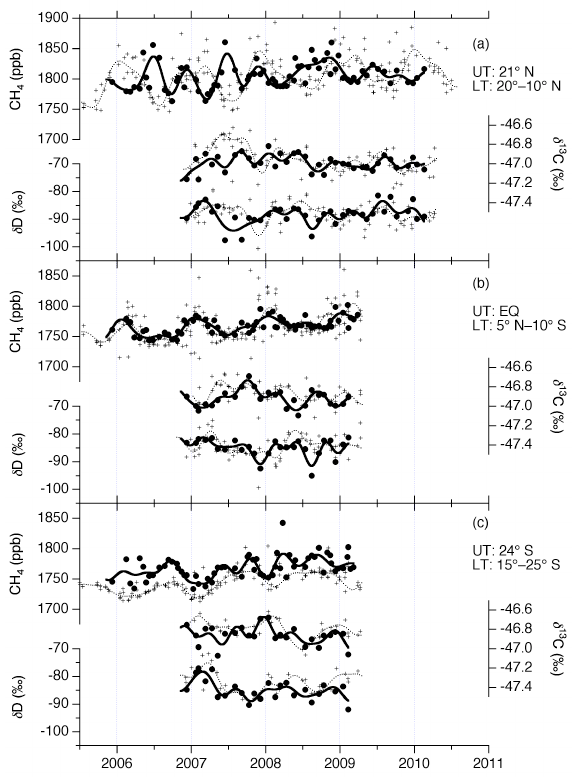
Fig. 4. Variations of the CH 4 mixing ratio, δ 13 C and δ D in the Figure 4. Variations of the CH 4 mixing ratio, δ 13 C and δ D in the UT (closed circles) and LT 1007 UT (closed circles) and LT (crosses) over the Western Pacific. Also shown are the best-fit curves to the UT (solid line) and LT (dotted (crosses) over the western Pacific. Also shown are the best-fit curves to the UT (solid line) 1008 line) and LT (dotted line) data. 1009